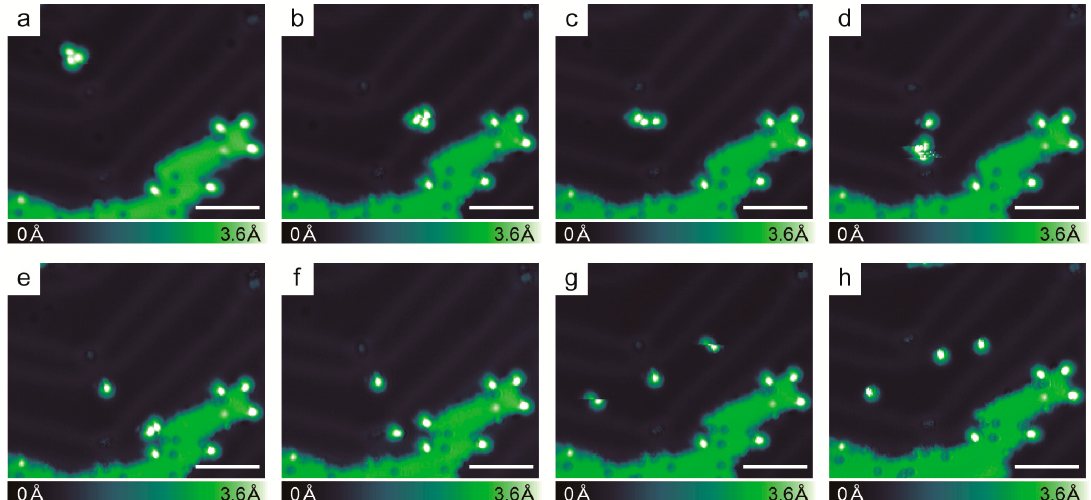
Figure 3. Manual separation of an asymmetric trimer into three isolated helicene monomers. ( a – d ) STM images of lateral manipulation process for separating the trimer into one monomer and one dimer. ( e – h ) STM images of lateral manipulation process for separating the dimer into two monomers. ( h ) STM image of successful manual separation of the trimer to three isolated monomers. Scanning parameters: 300 mV, 10 pA, scale bars 5 nm.